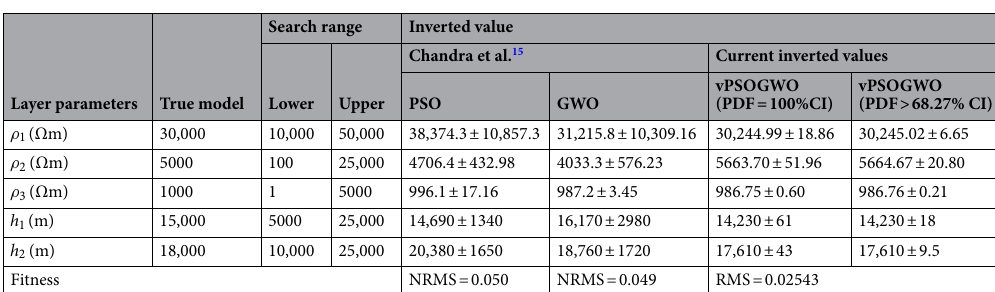
Table 3. Mean model with the level of uncertainty in the posterior utilizing individual inversion of MT synthetic data distorted with 10% noise from vPSOGWO compared with results inverted by Chandra et al. 15